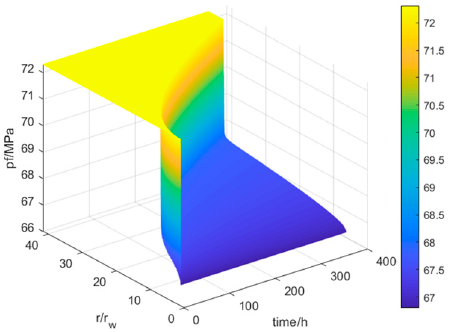
Figure 10. Variation in fracturing pressure with time and dimensionless distance.